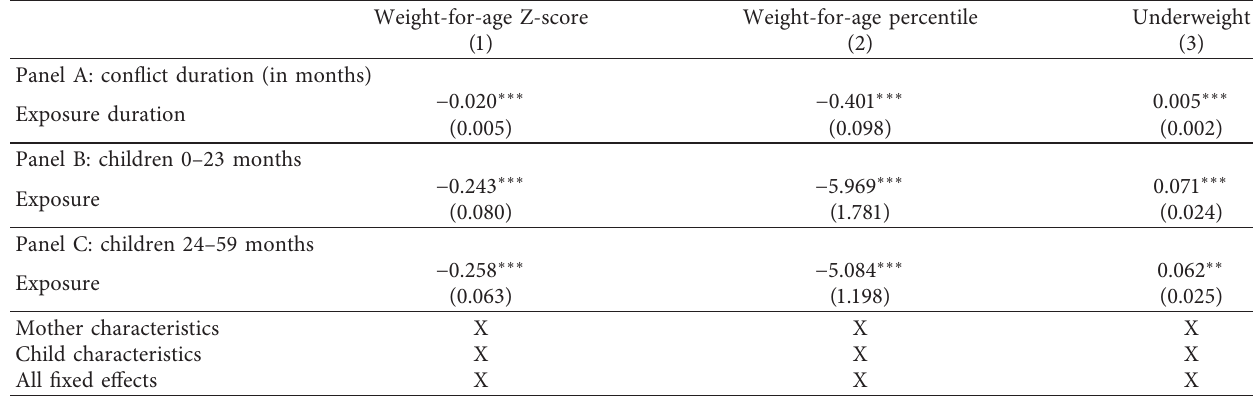
Table 5: Exposure to armed conflict on child weight-for-age: other tests.